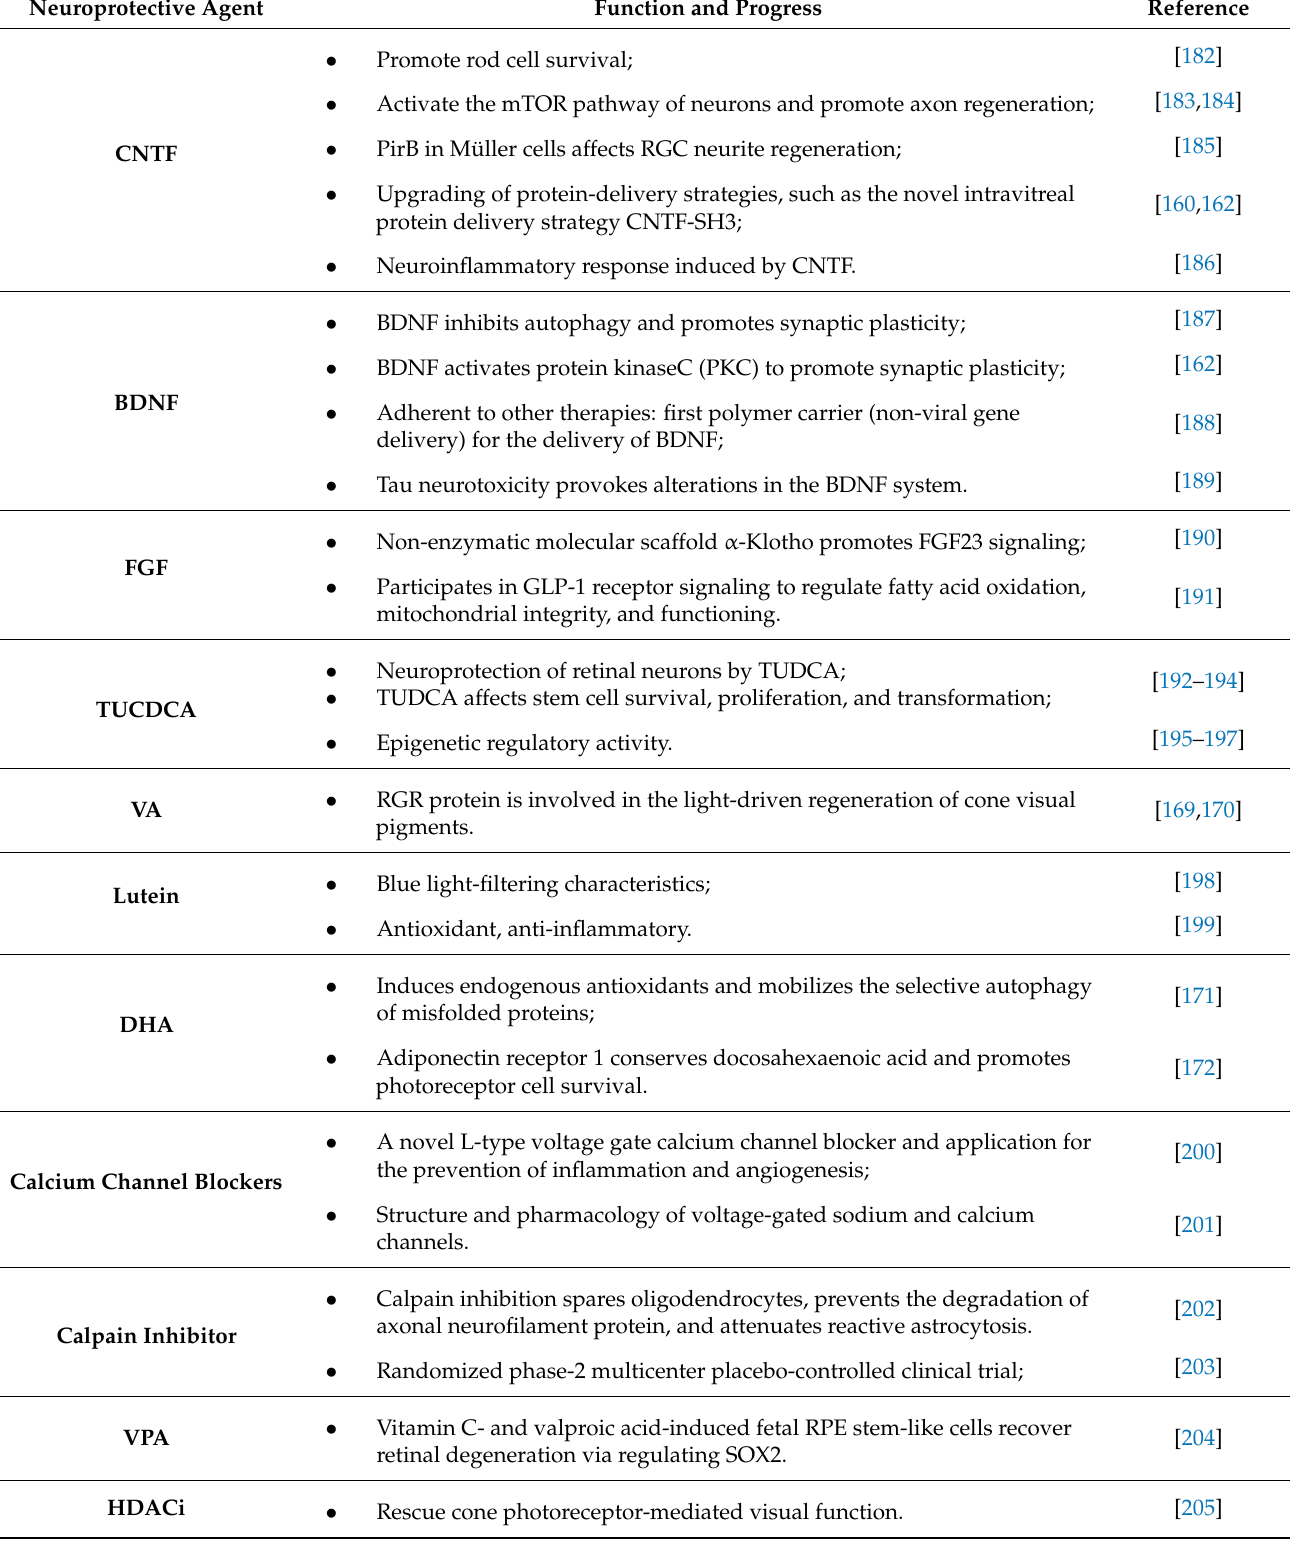
Table 2. Neuroprotective agents in pharmacological